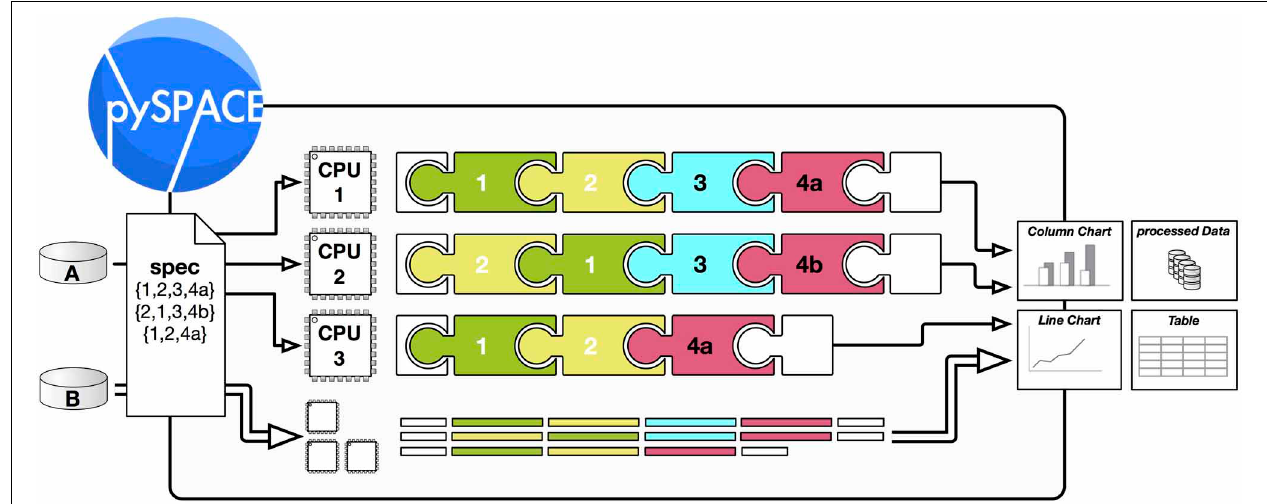
FIGURE 3 | Processing scheme of a node chain operation in pySPACE. A and B are two different datasets (section 2.1), which shall be processed as specified in a simple spec file (section 3.2). The processing is then performed automatically. As a result , it can produce new data but also visualizations and performance charts. To speed up processing the different